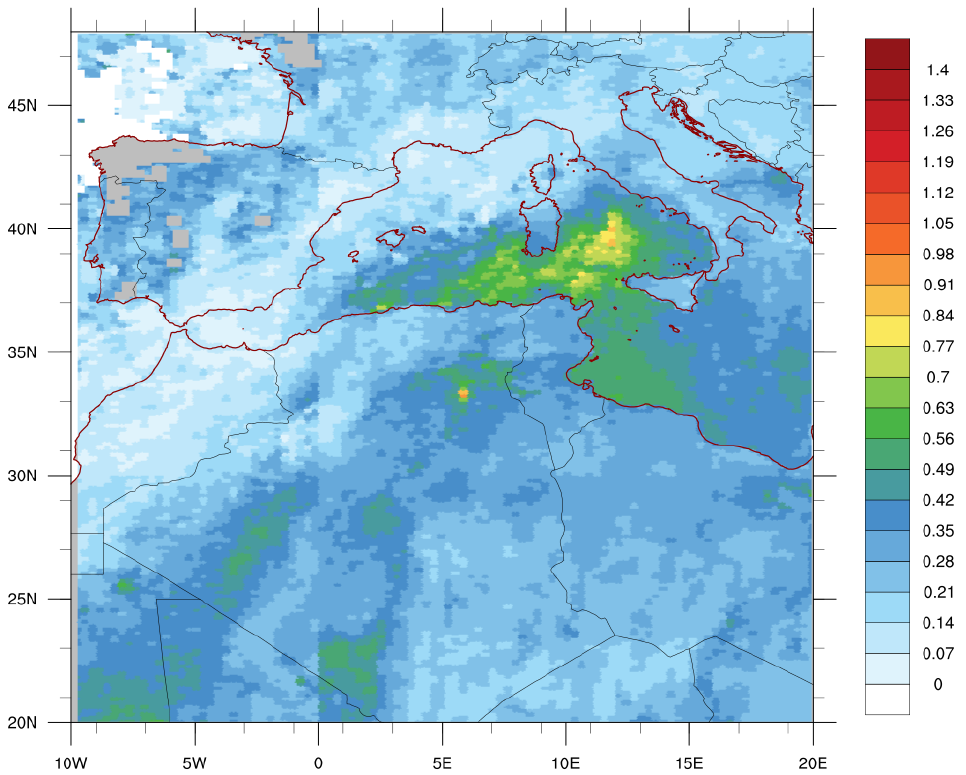
Remote Sens. 2023 , 15 , x FOR PEER REVIEW Figure 2. Period averaged (17–24 June) aerosol optical depth at 0.55 µ m from Modis-MAIAC. Figure 2. Period averaged (17–24 June) aerosol optical depth at 0.55 μ m from Modis-MAIAC.